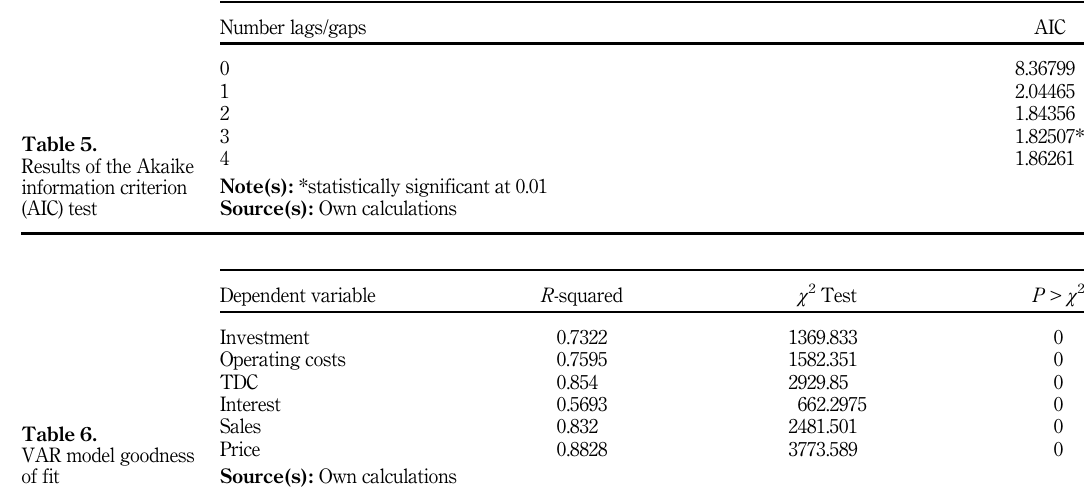
Table 6. VAR model goodness of